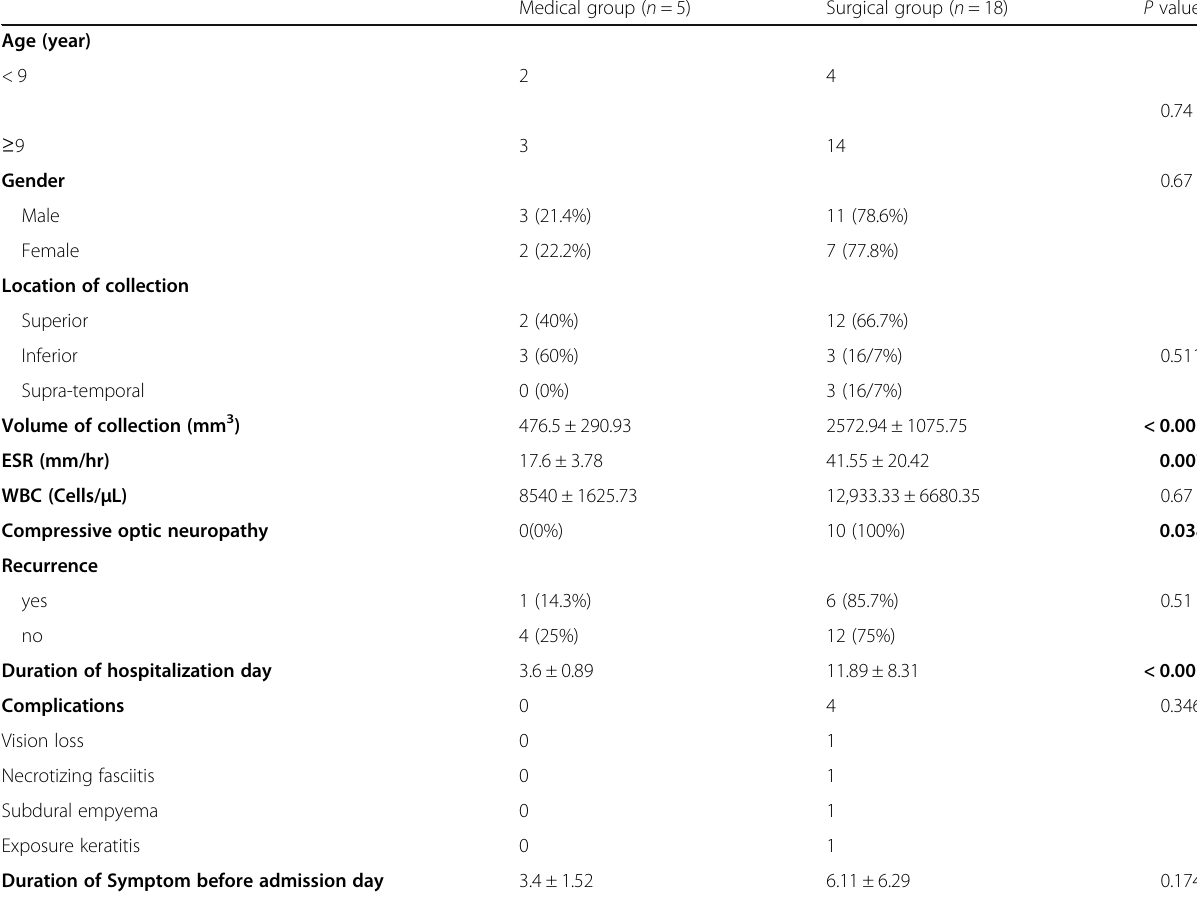
Table 1 Laboratory data, radiological finding, and complications of patients in both medical and surgery groups Medical group ( n = 5)